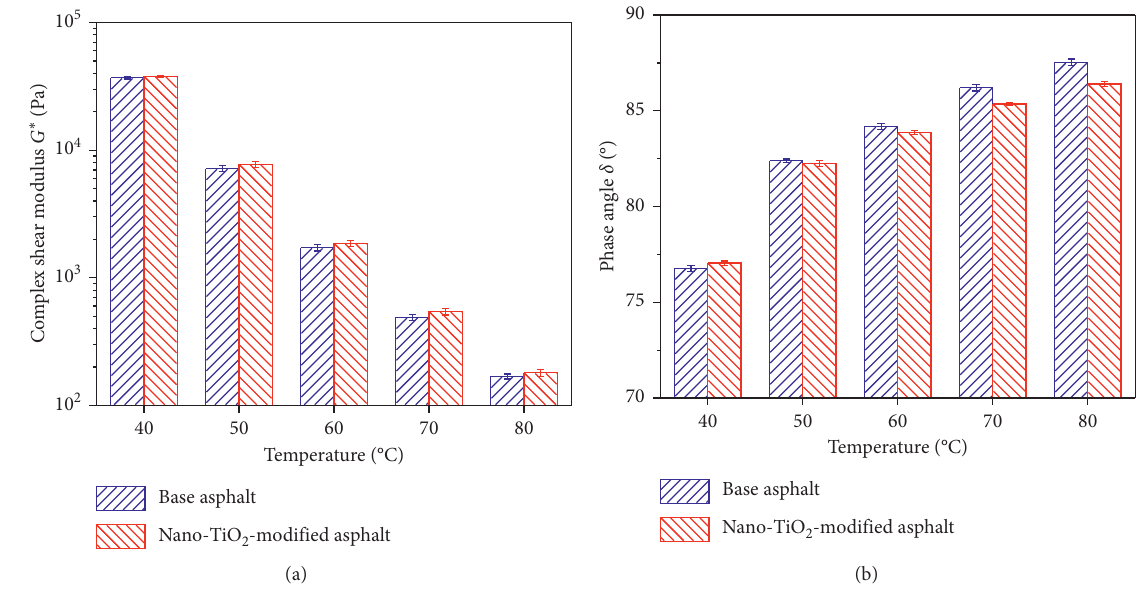
Figure 5: Temperature sweep test of asphalt with and without nano-TiO